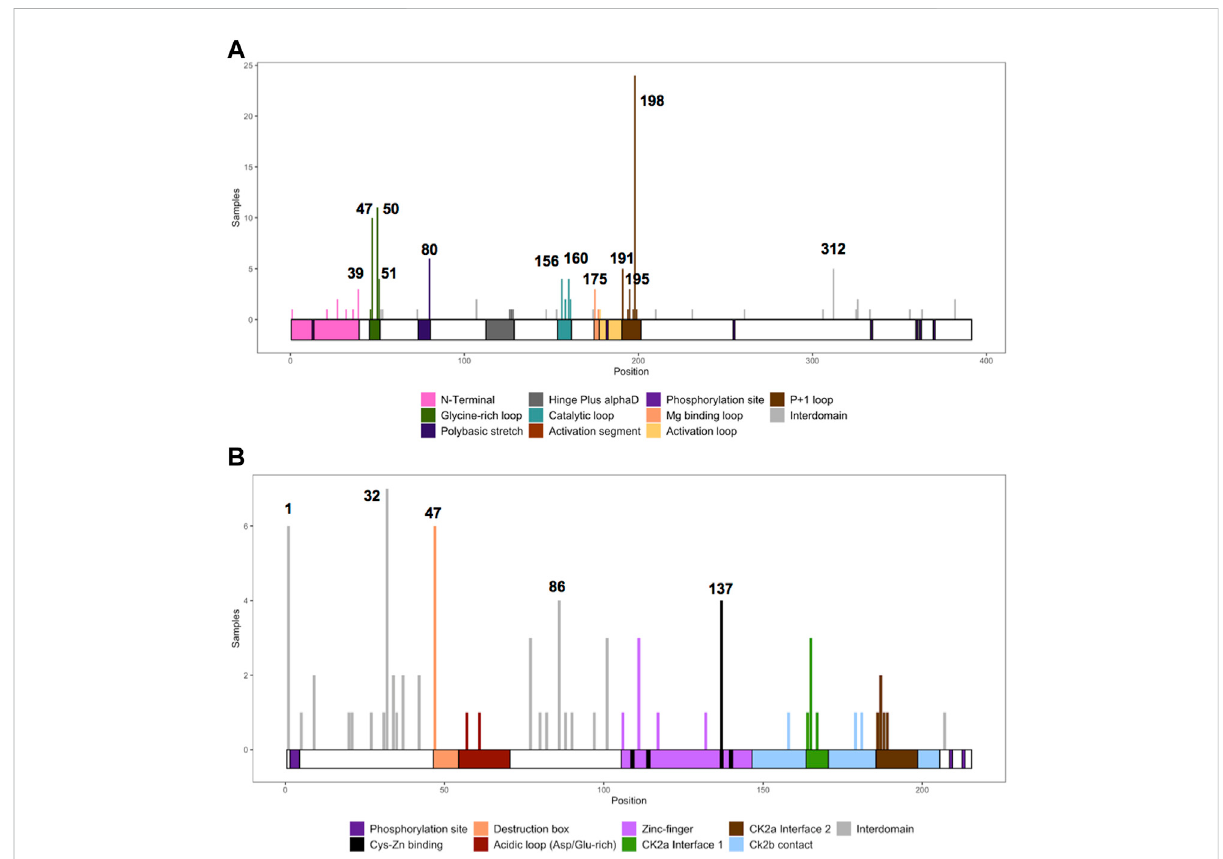
FIGURE 3 Histogram representing the number of mutations along the primary sequence of CK2 α and CK2 β . The X-axis represents the primary sequence and the functional domains of CK2 α (A) and CK2 β (B) . The Y axis represents the number of patients with missense, nonsense, and frameshift mutations along the primary structure of CK2 α and CK2 β . Numbers in the histogram represent single residues found signi fi cant in the non-random mutation cluster (NMC)